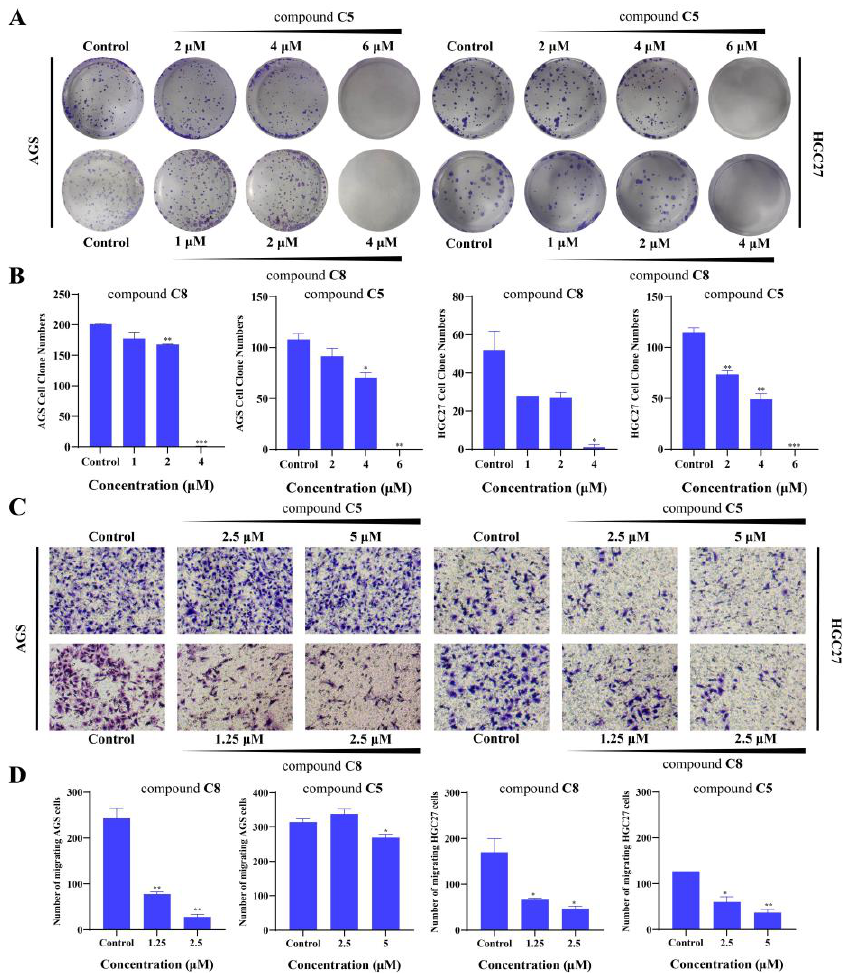
Figure 3. The proliferation and migration of AGS and HGC27 cells were inhibited after treatment compounds C5 or C8 for 48 h. ( A ) The proliferation of AGS and HGC27 cells were inhibited for treatment of different concentrations of compounds C5 or C8 for 48 h. ( B ) Statistical analysis of AGS and HGC27 cell migration numbers. ( C ) The proliferation of AGS and HGC27 cells was inhibited after the treatment of compounds C5 and C8 for 8 – 10 days. ( D ) Statistical analysis of AGS and HGC27 cell proliferation numbers. Values are shown as the means ± standard. * p < 0.05, ** p < 0.01, *** p < 0.001 compared to negative DMSO control group.